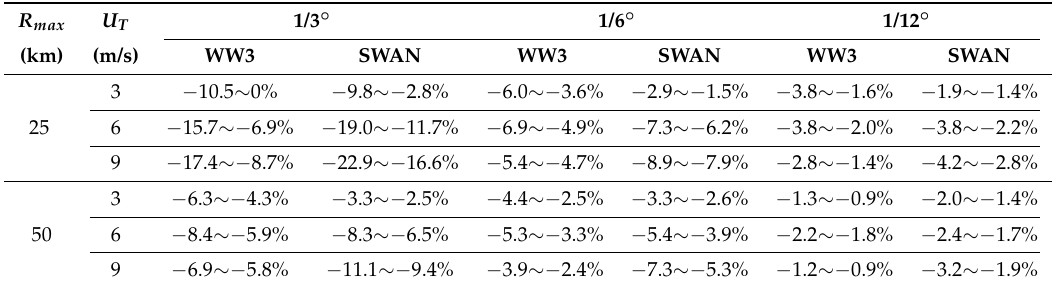
Table A1. Maximum underestimation of the local SWH at right front R max with different resolutions relative to results with 1/24 ◦